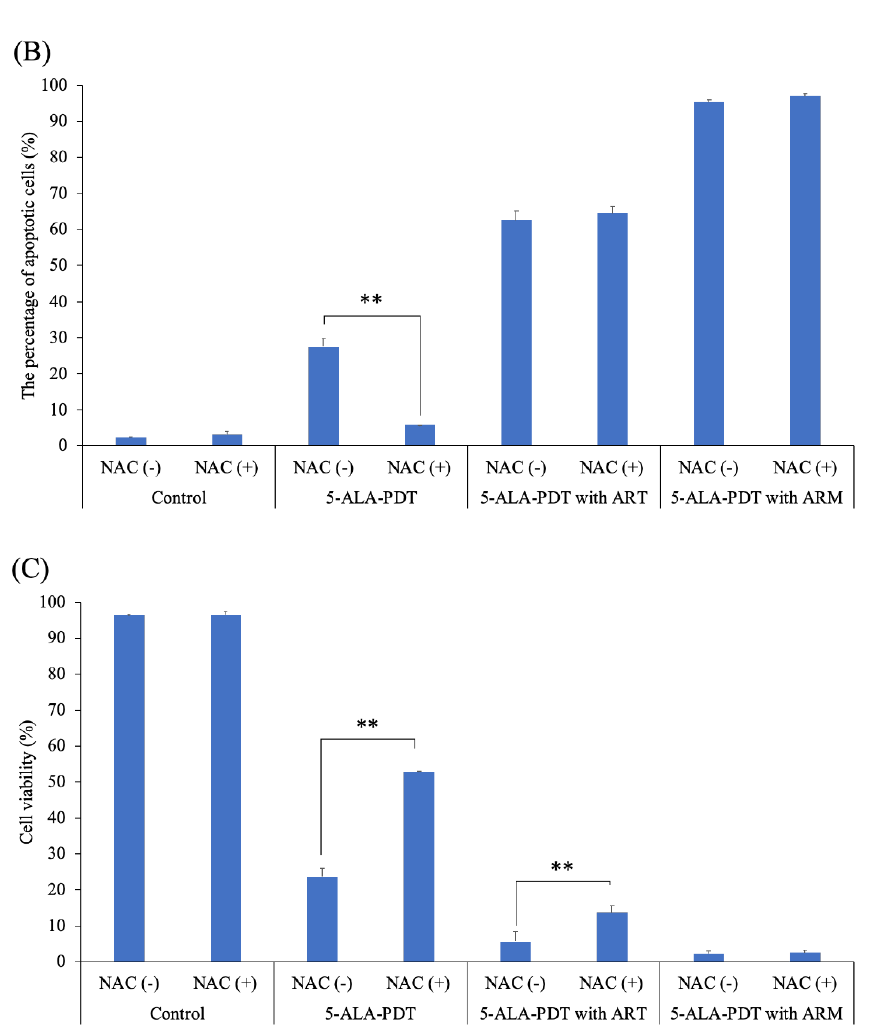
Figure 6. The percentage of ROS-positive cells in the presence or absence of N-acetylcysteine (NAC). EMT-6 cells were treated with 5-aminolevulinic acid (5-ALA)-PDT only or 5-ALA-PDT with artesunate (ART) or artemether (ARM) in the presence (10 mM) or absence of NAC. ROS’ induction by 5-ALA-PDT only ( p = 0.0023) or 5-ALA-PDT with ARM ( p < 0.0001) was significantly inhibited by NAC ( A ). Apoptosis’s induction by 5-ALA-PDT only ( p < 0.0001) was significantly inhibited by NAC ( B ). Cytotoxicity, exhibited by 5-ALA-PDT only ( p < 0.0001) or 5-ALA-PDT with ART ( p = 0.0003), was significantly inhibited by NAC ( C ). Data were analyzed using Sidak’s multiple comparison test (** p < 0.01; NAC ( − ) vs. NAC ( + )). Results are presented as means ± standard